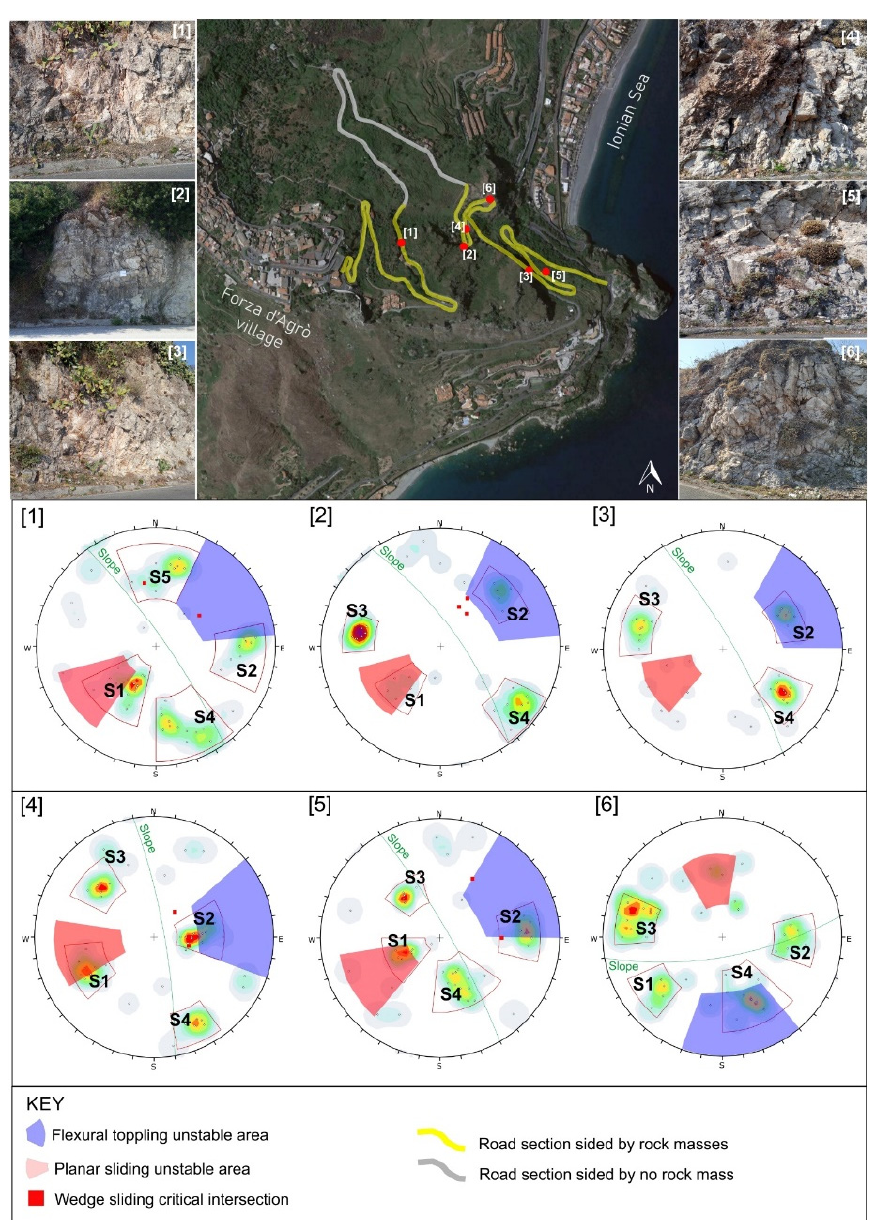
Figure 4. Location of the rock mass survey stations (on a satellite image by Google Earth) and geostructural diagrams showing the kinematic settings of the studied